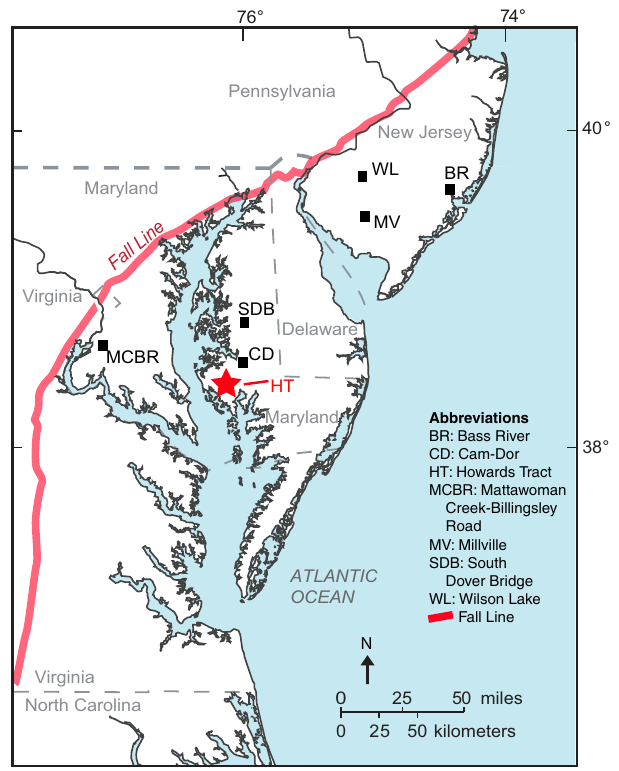
Fig. 1 | Location of the Howards Tract cores on the mid-Atlantic Coastal Plain, the area east of the Fall Line (adapted from Bralower, T.J. et. al. 38 ). Fall line represents the paleo-shoreline of the Atlantic Ocean during the Paleocene-Eocene Thermal Maximum (PETM).BR Bass River; CD Cam-Dor; HTHowards Tract; MCBR Mattawoman Creek-Billingsley Road; MV Millville; SDB South Dover Bridge; WL Wilson